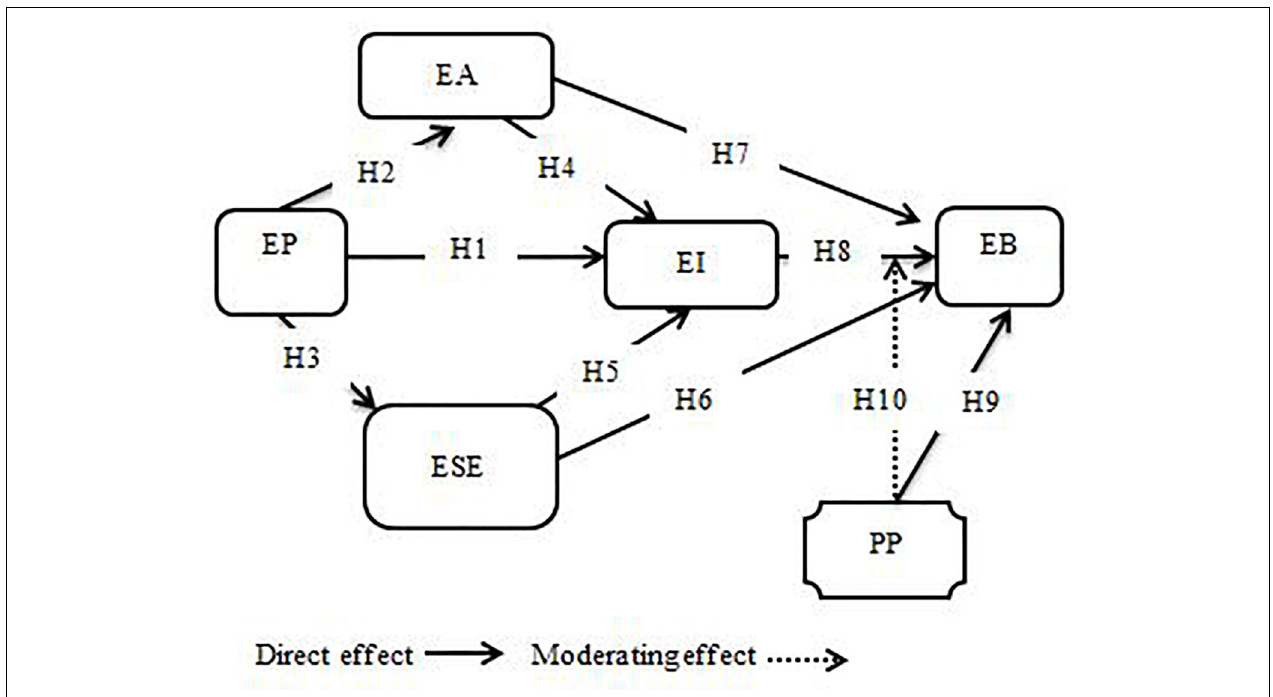
FIGURE 1 | Conceptual